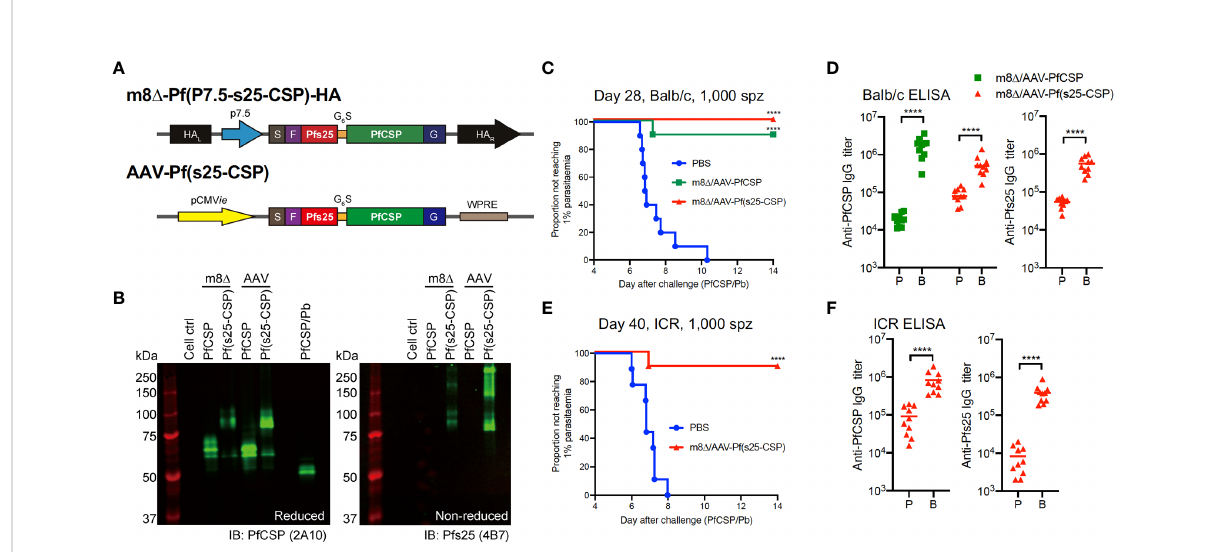
FIGURE 1 Protective ef fi cacy against low-dose sporozoites. (A) Construction of recombinant m8 D and AAV. HA, hemagglutinin; p7.5, 7.5 promoter; pCMVie, CMV immediate early promoter; S, signal sequence; F, FLAG epitope tag; G6S, GGGGGGS hinge sequence; G, VSV-G TM; WPRE, woodchuck hepatitis virus posttranscriptional regulatory element. (B) Western blotting of viral-transduced HEK293T cells. (C, E) Protective ef fi cacy in Balb/c mice (C) and ICR mice (E) immunized with m8 D /AAV-Pf(s25-CSP) (n = 10) and m8 D /AAV-PfCSP (n = 10) against 1,000 PfCSP/ Pb sporozoites at day 28 (Balb/c) or day 40 (ICR) after the last immunization. P values were calculated by log-rank (Mantel – Cox) tests versus the PBS group. (D, F) IgG antibodies against PfCSP and Pfs25 at 41 days after priming “ P ” and 27 days after boosting “ B ” in Balb/c mice (D) , or 41 days after priming and 39 days after boosting in ICR mice (F) . P values were calculated using Mann – Whitney tests. ****p <